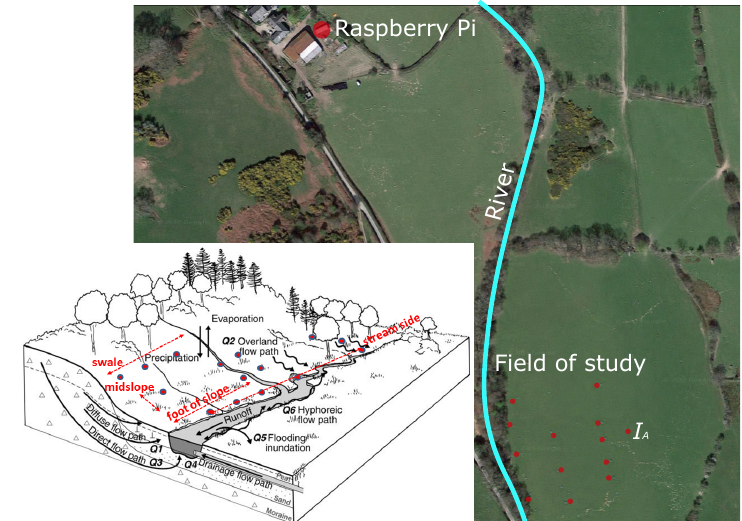
Figure 3. The deployment location of our IoT system, showing a geographical view of the entire deployment as well as a detailed technical view of the field of study in hydrological terms: Mobile (livestock) nodes are not shown on the geographical view, but tracked animals are located within the treeline enclosing the area marked “field of study” (courtesy of Satellite image from Google Earth).